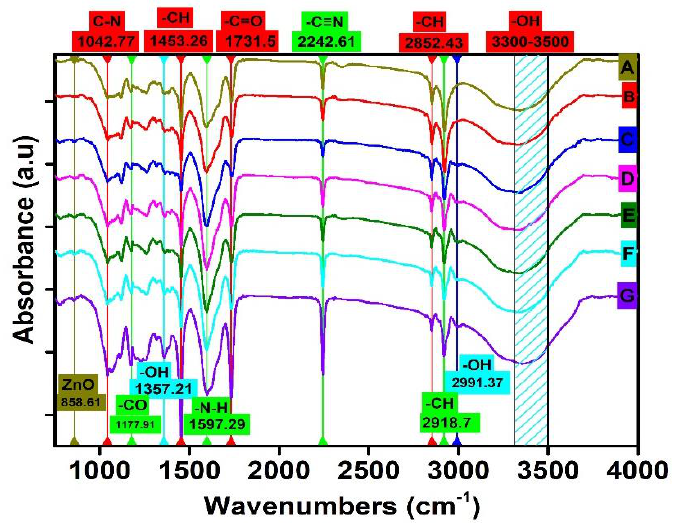
Figure 5. FTIR Analysis of VB-loaded ZnO/PAN electrospun nanofibers: ( A ) pristine PAN electro- spun nanofibers; ( B ) ZnO/PAN electrospun nanofibers; ( C ) 0.5% VB-loaded ZnO/PAN electrospun nanofibers; ( D ) 1.5% VB-loaded ZnO/PAN electrospun nanofibers; ( E ) 2.5% VB-loaded ZnO/PAN electrospun nanofibers; ( F ) 3.5% VB-loaded ZnO/PAN electrospun nanofibers; ( G ) 5% VB-loaded ZnO/PAN electrospun nanofibers.